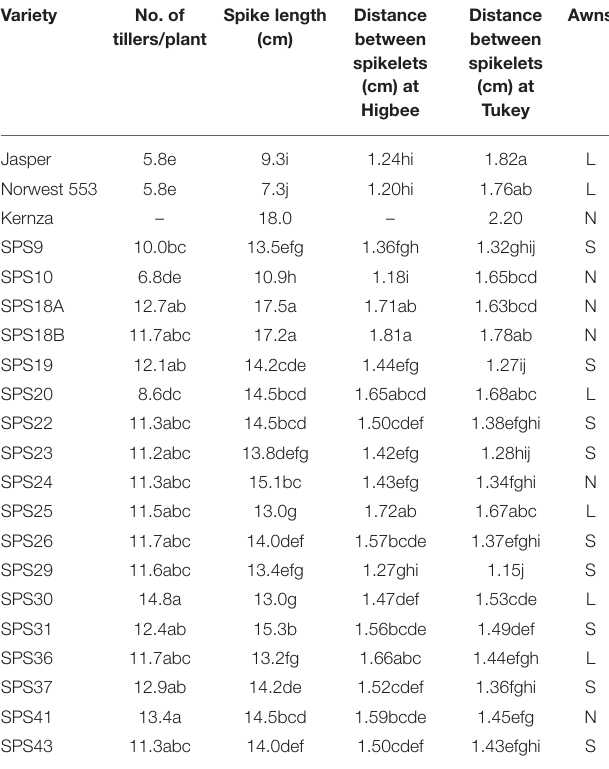
TABLE 4 | Tiller and spike characteristics for all varieties, including mean number of tillers per plant, mean spike length, mean distance between spikelets at